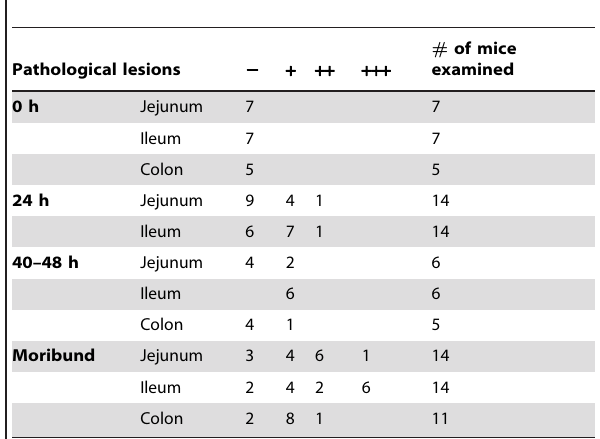
Table 1. Summary of pathological findings*.